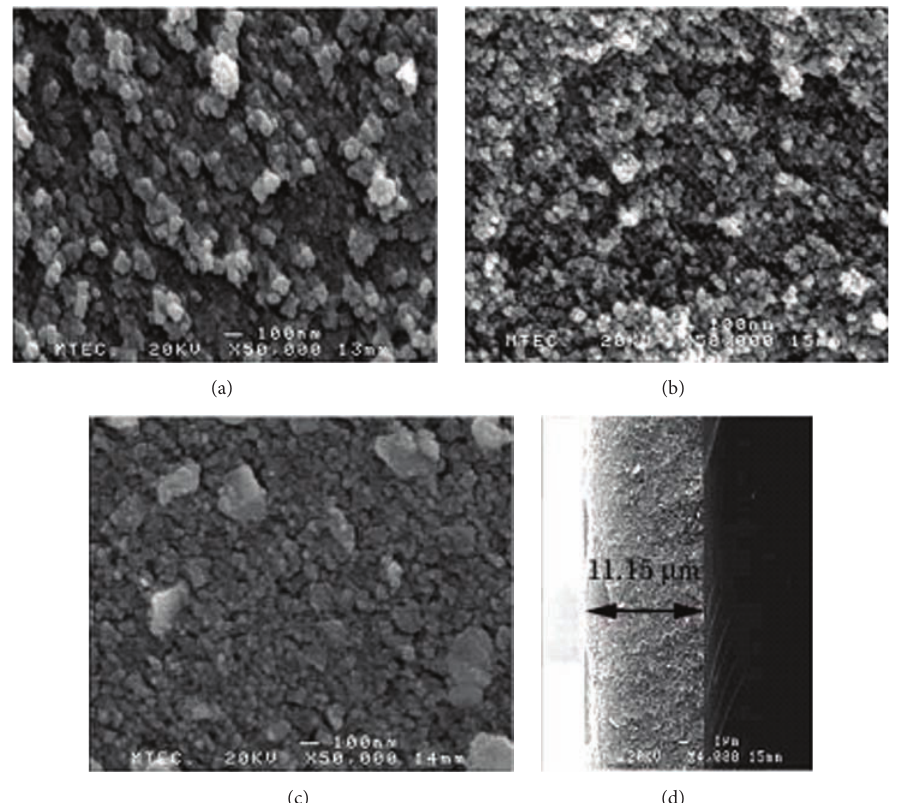
Figure 4: SEM images of TiO 2 /MgO/Ag composite films: (a) bare-TiO 2 , (b) TiO 2 /MgO (0.10nm)/Ag (4.4nm), (c) TiO 2 /MgO (0.46 nm)/Ag (4.4 nm), and (d) cross section of TiO 2 /MgO (0.10nm)/Ag (4.4 nm).